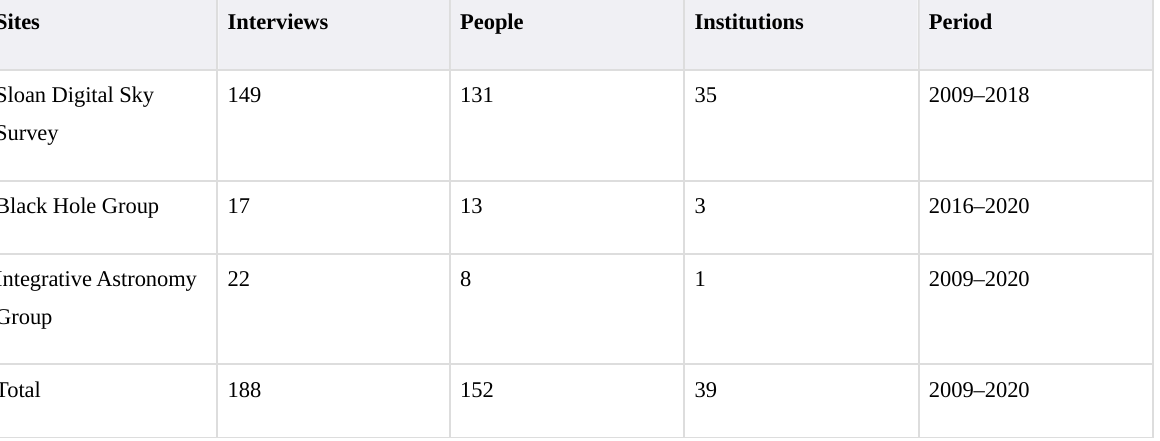
Table 1. Astronomy interviews analyzed for this